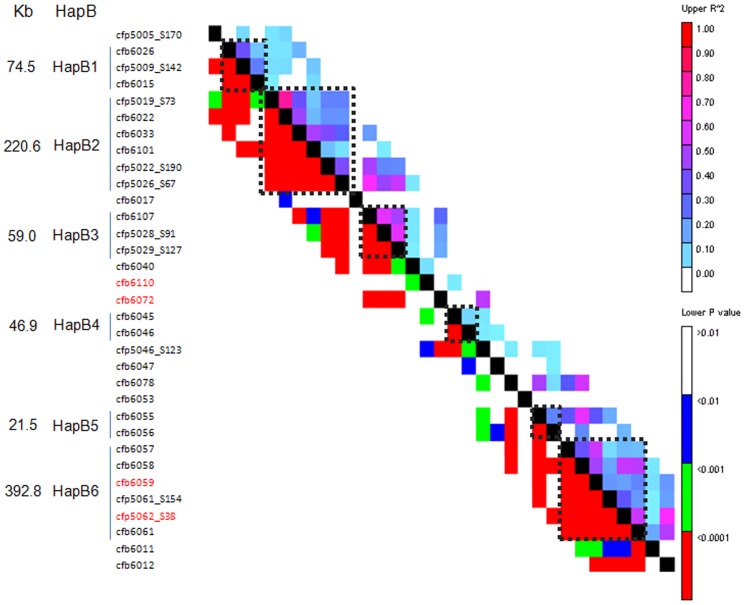
Haplotype blocks (HapB) and physical distances (Kb) defined by sliding window LD of 5 marker sets at the level of r2>0.1 and P<0.001.Red markers are those significantly associated with scab-related traits in this study.